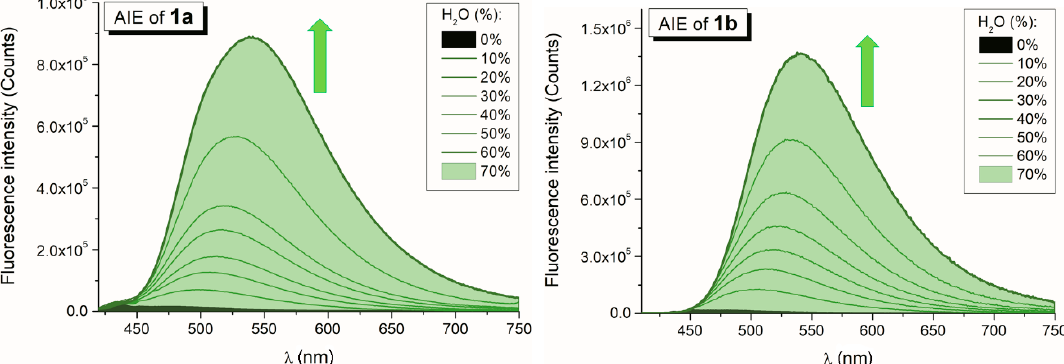
Figure 1. Fluorescence spectra of 1a ( left ) and 1b ( right ) in THF/water mixtures with different water fractions. AIE, aggregation-induced emission.